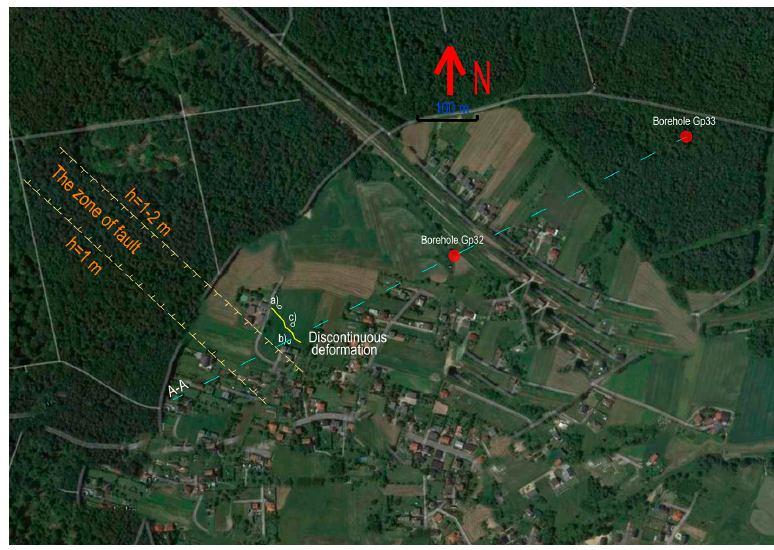
Figure 5. The course of the discontinuous deformation (red lines) and the locations of the selected damages (white dots). Energies 2020, 13, x FOR PEER REVIEW